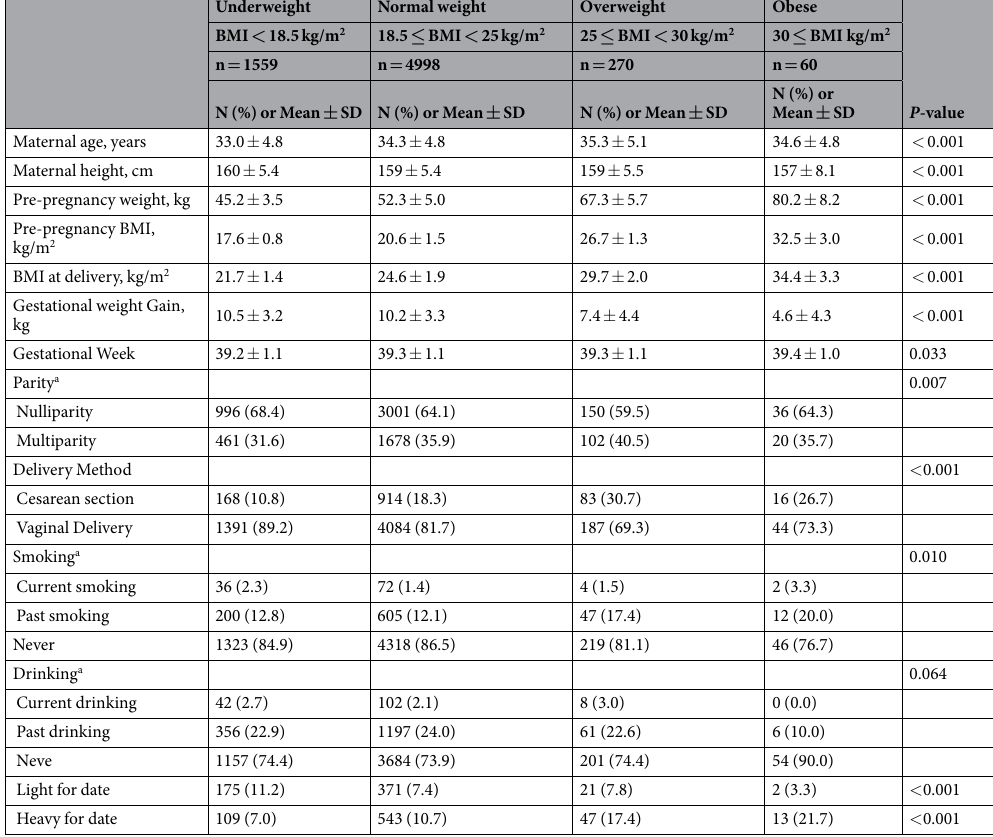
Table 1. Baseline characteristics according to a level of pre-pregnancy BMI. Based on a chi-square test or a Fisher Exact test for categorical variables and an analysis of variance for continuous variables. a Summation does not reach total number due to missing